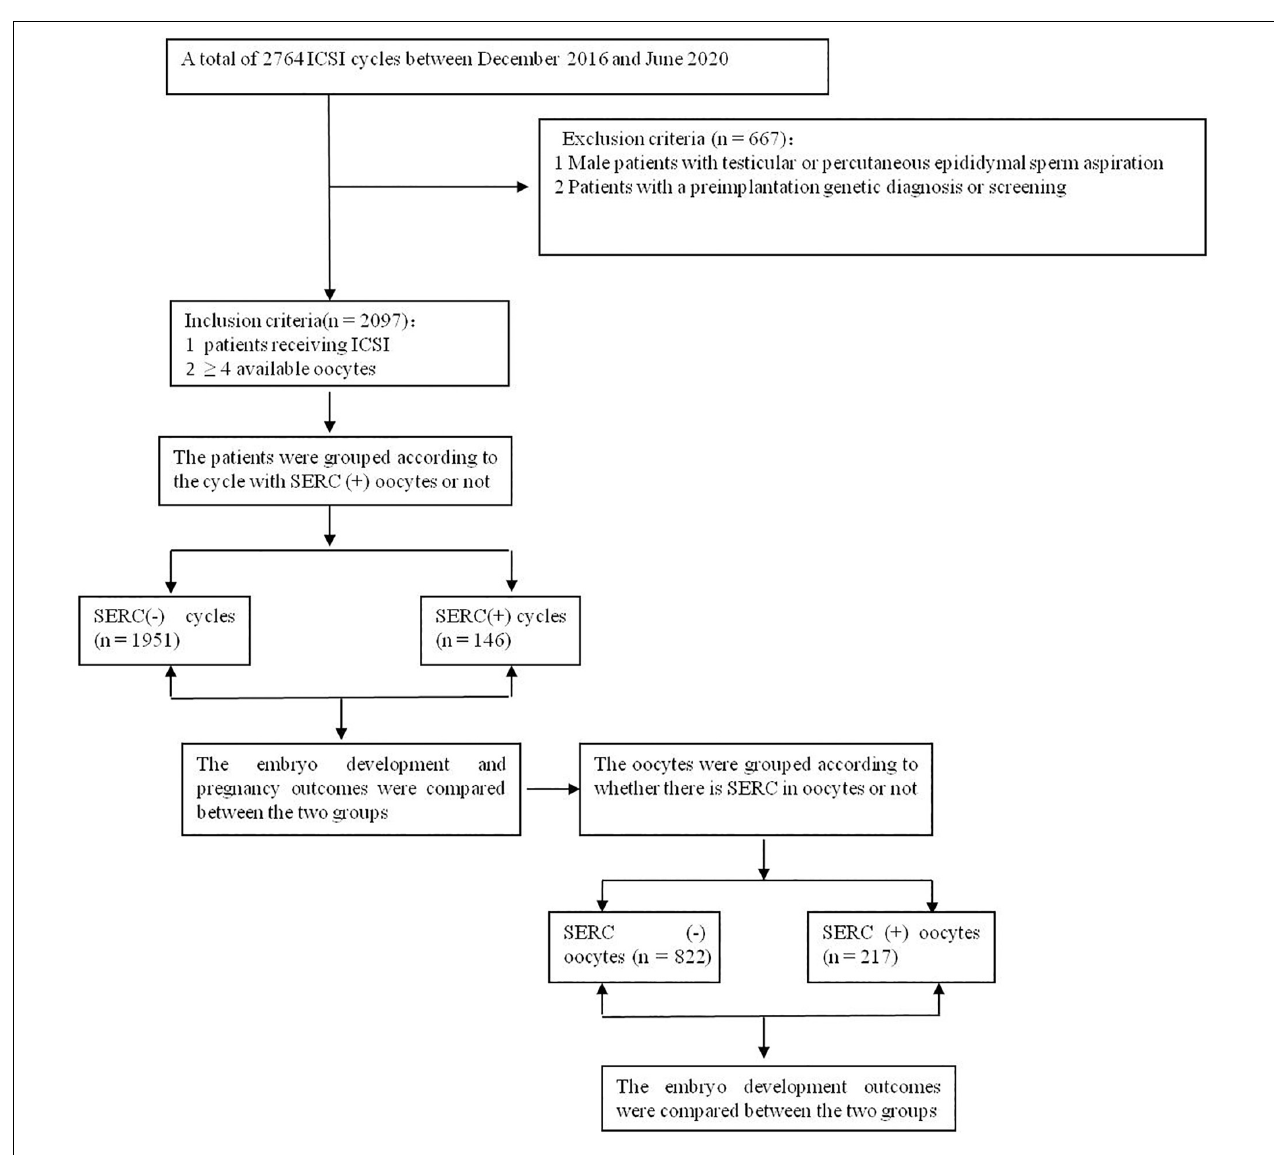
FIGURE 1 | Flow chart of inclusion of patients in this